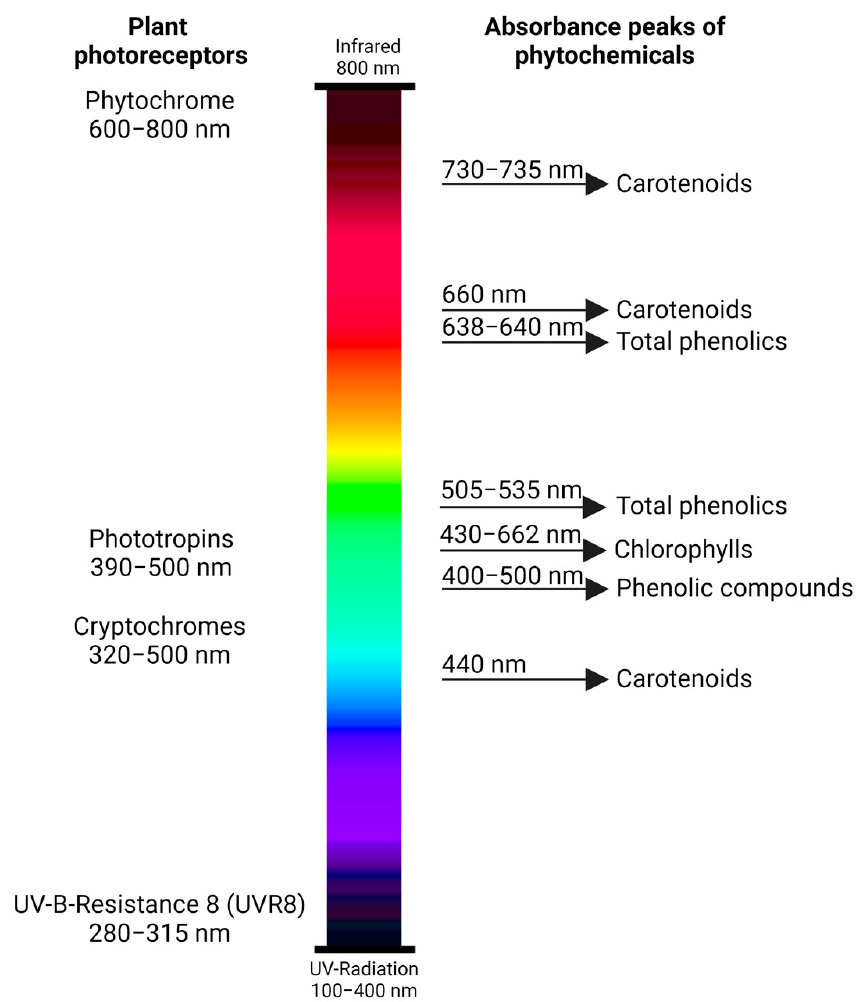
Figure 1. Plant photoreceptors (phytochrome, phototropins, cryptochromes, and UV-B-Resistance 8 (UVR8)) with the corresponding absorbance peaks (wavelengths of the electromagnetic spectrum) for each light-sensing photoreceptor protein. The light-responding groups of phytochemicals in plants in the specific wavelength ranges are provided on the right.